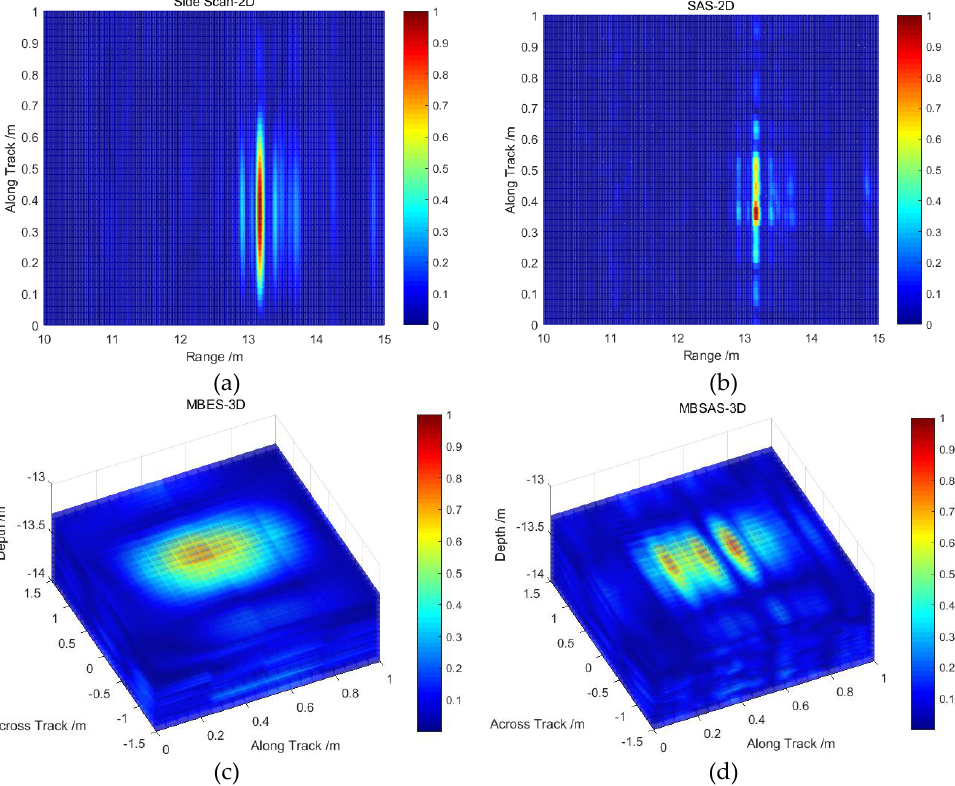
Figure 15. Comparison of imaging algorithms: cube target imaging results via ( a ) side-scan sonar; ( b ) SAS; ( c ) MBES; and ( d ) MBSAS.